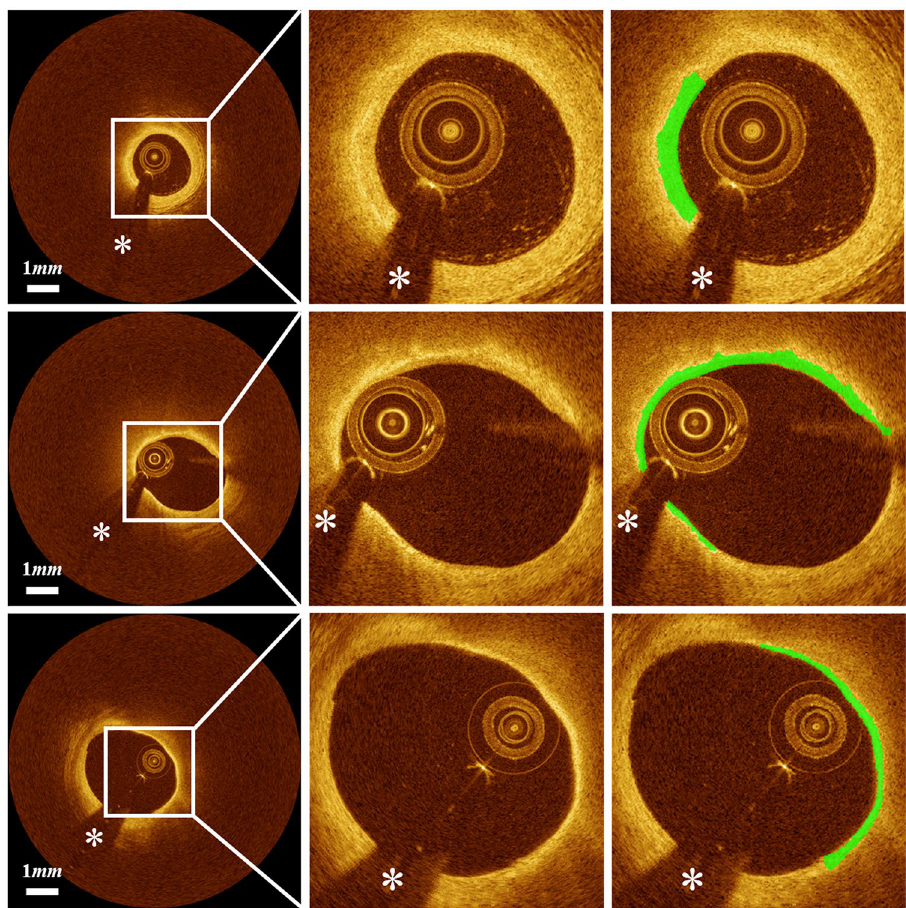
Figure 6. Automated thin-cap fibroatheroma detection results on the held-out test set: (left) original IVOCT image, (center) cropped image for better visualization, and (right) cropped image overlaid with fibrous cap detection. Green is fibrous cap, and white asterisk (*) is the guidewire shadow.